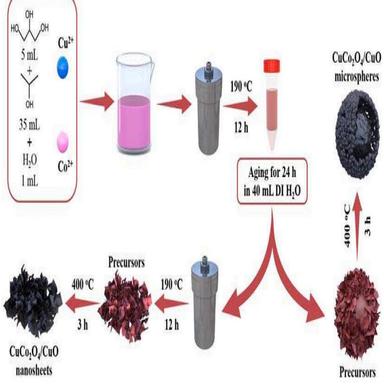
The schematic illustration for the synthesis of CuCo2O4/CuO microspheres and CuCo2O4/CuO nanosheets.